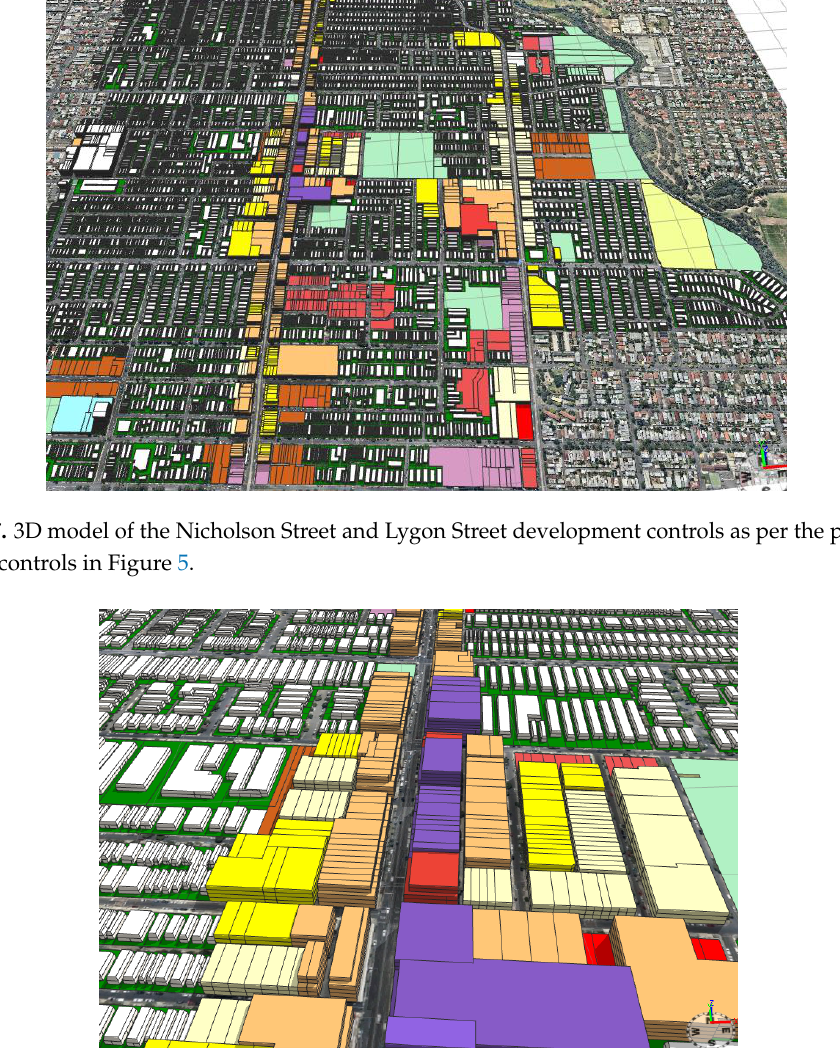
Figure 8. Closer inspection of Lygon Street (Shadowing time set at 10:00 a.m. in March).